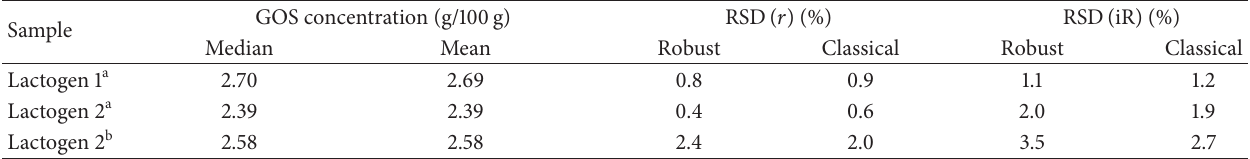
Table 5: Precision of GOS analysis in infant formula.